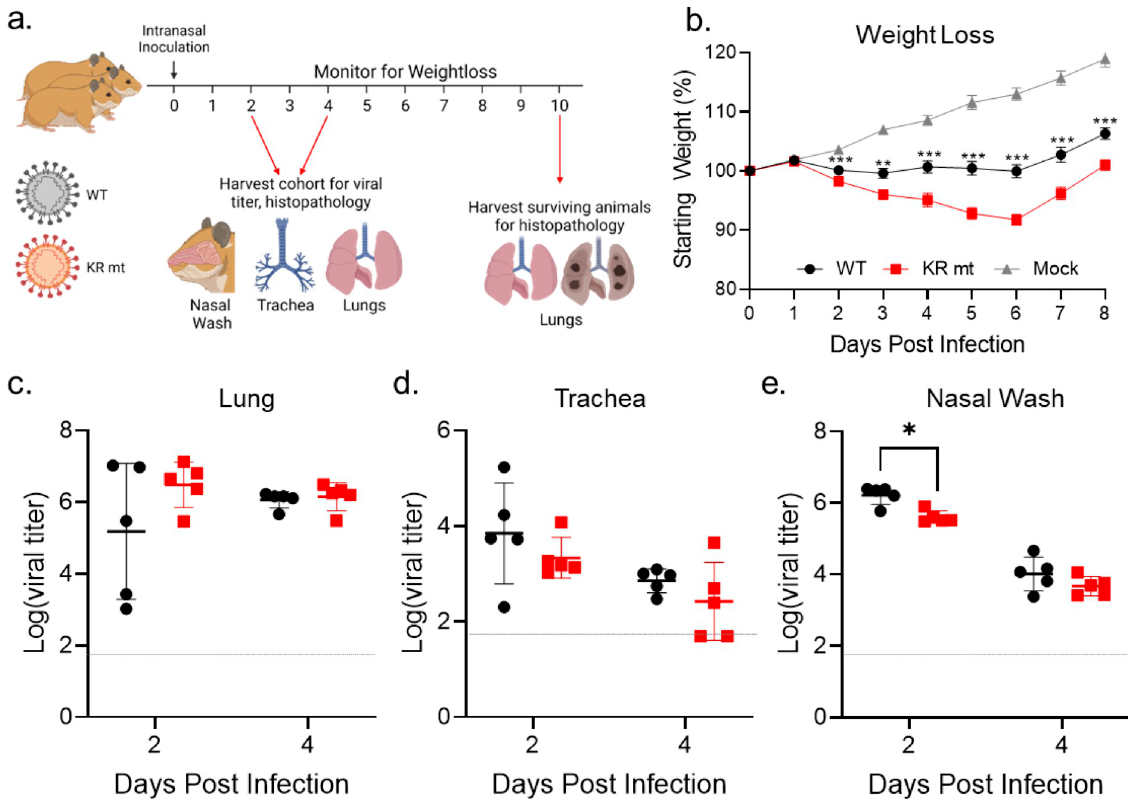
Fig 2. The KR mt enhances SARS-CoV-2 pathogenesis. ( A ) Schematic of the infection of hamsters with SARS-CoV-2. ( B-E ) Three- to four- week-old male hamsters were mock-infected (gray) or inoculated with 10 4 PFU of WT SARS-CoV-2 (black) or the KR mt (red). Animals were then monitored for weight loss (B). On days 2 and 4 post infection, viral titers in the lung (C), trachea (D), and from nasal washes (E) were determined. For weight loss data, mean percent weight loss was graphed ± s.e.m. For titer data, individuals were graphed with means ± s.d. indicated by lines. Statistical significance between WT and the KR mt was determined by student’s T-Test with 0p � 0.05 ( � ), p � 0.01 ( �� ), and p � 0.001 ( ��� ). Grey dotted lines are equal to LOD. Schematic in (A) was generated by authors using Biorender.com.